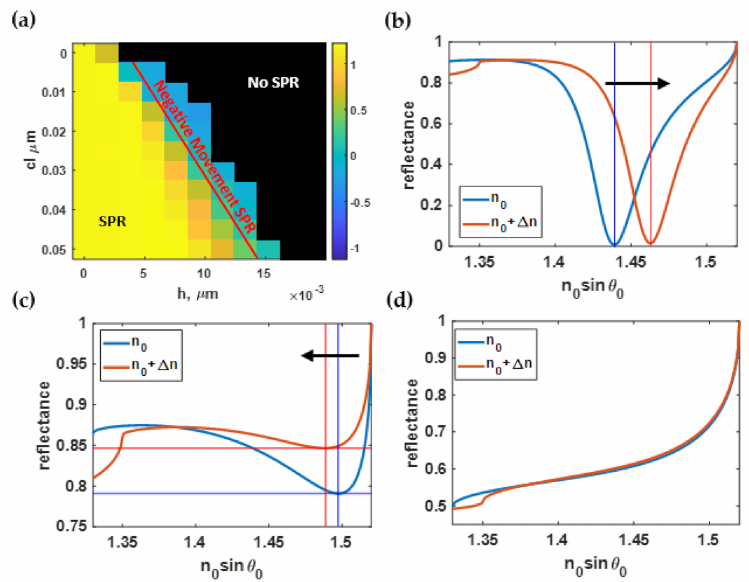
Figure 8. ( a ) Sensitivity calculated using Monte Carlo simulation; ( b ) SPR dips at h of 1 nm and cl of 50 nm; ( c ) negative SPR dip movement at h of 9 nm and cl of 15 nm; and ( d ) reflectance when there was no SPR dip present at h of 15 nm and cl of 5 nm.